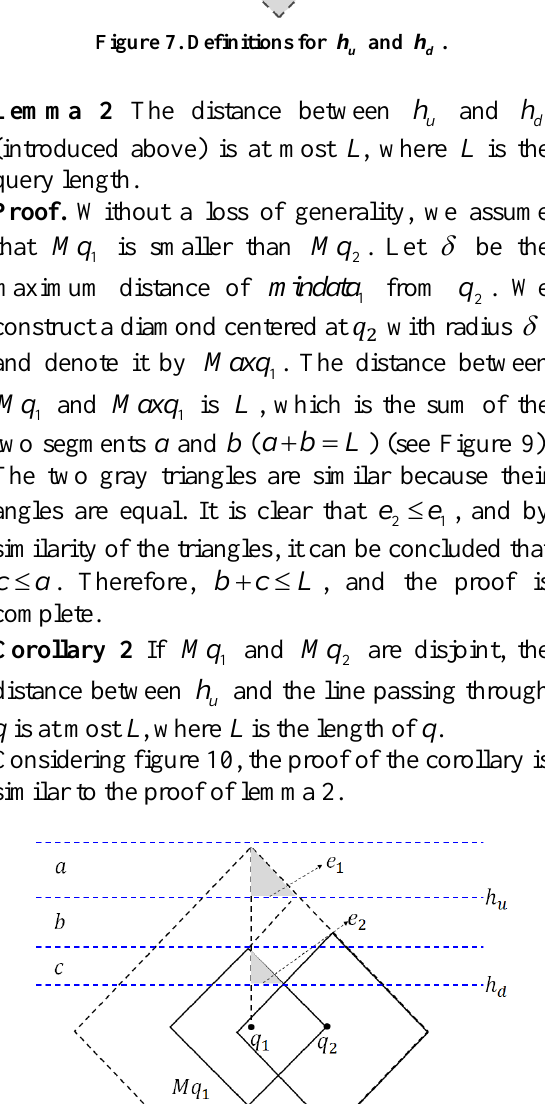
Figure 7. Definitions for